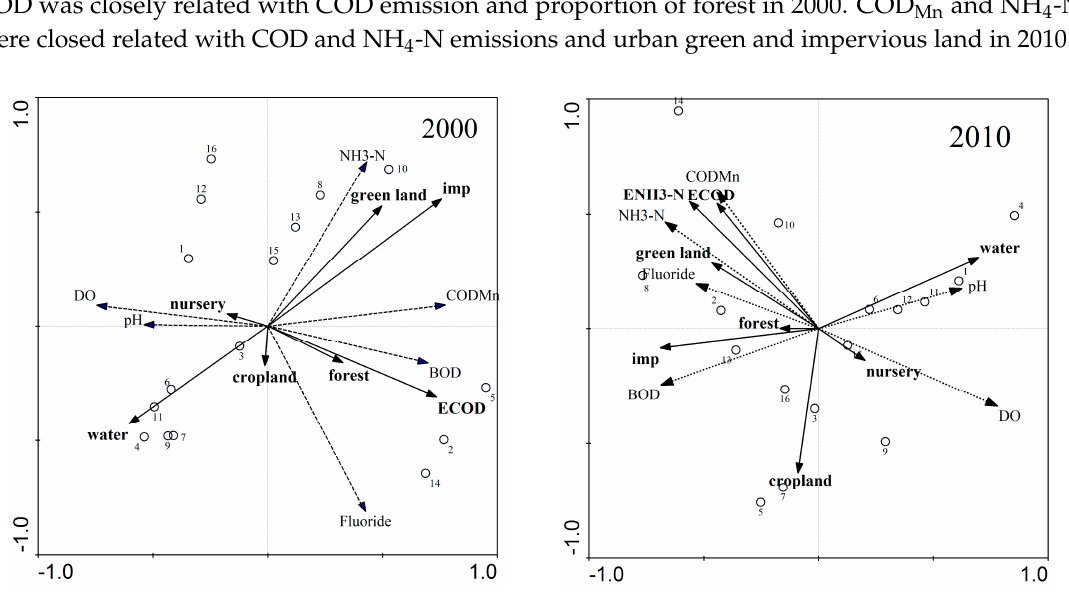
Figure 3. Redundancy analysis results of land use and water quality at 2000 m buffer in 2000 and 2010. “imp” refers to impervious surface; “DO”, “COD Mn ”, “BOD” and “NH 4 -N” refer to dissolved oxygen; permanganate index; biochemical oxygen demand and ammonium-nitrogen, respectively. “E COD ” and “E NH4-N ” refer to chemical oxygen demand emission and ammonium-nitrogen